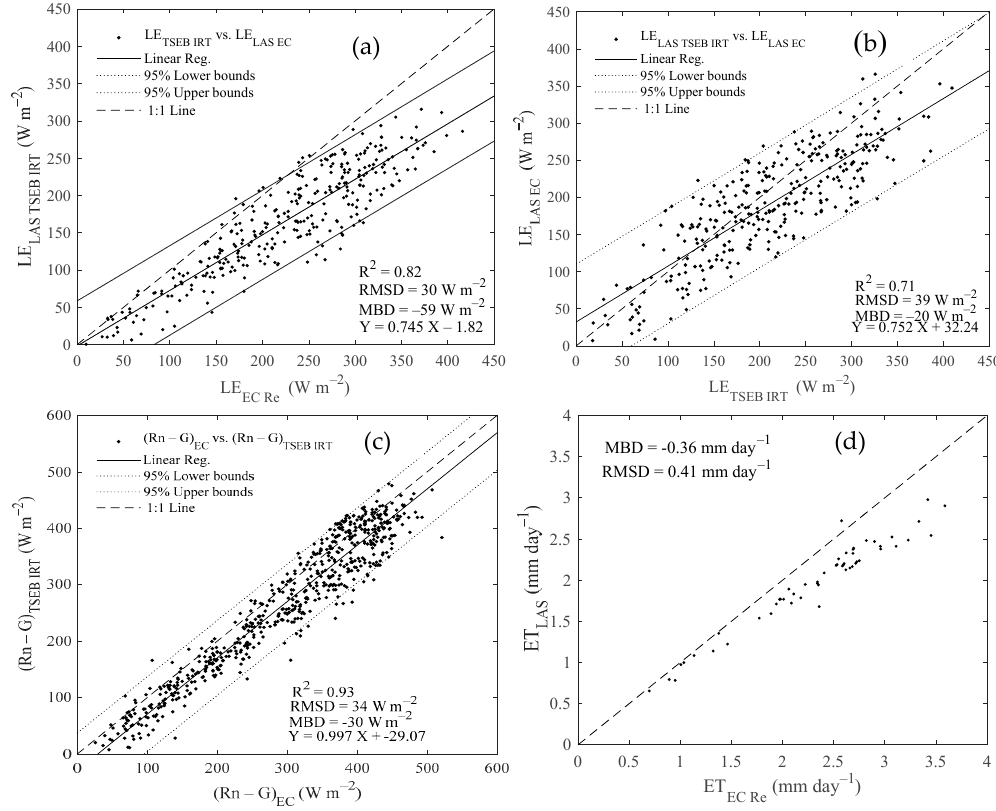
Figure 11. Comparisons between ( a ) LE LAS TSEB IRT and LE EC Re , ( b ) LE LAS EC and LE TSEB IRT , ( c ) (Rn − G) TSEB IRT versus (Rn − G) EC , and ( d ) ET LAS and ET EC Re .